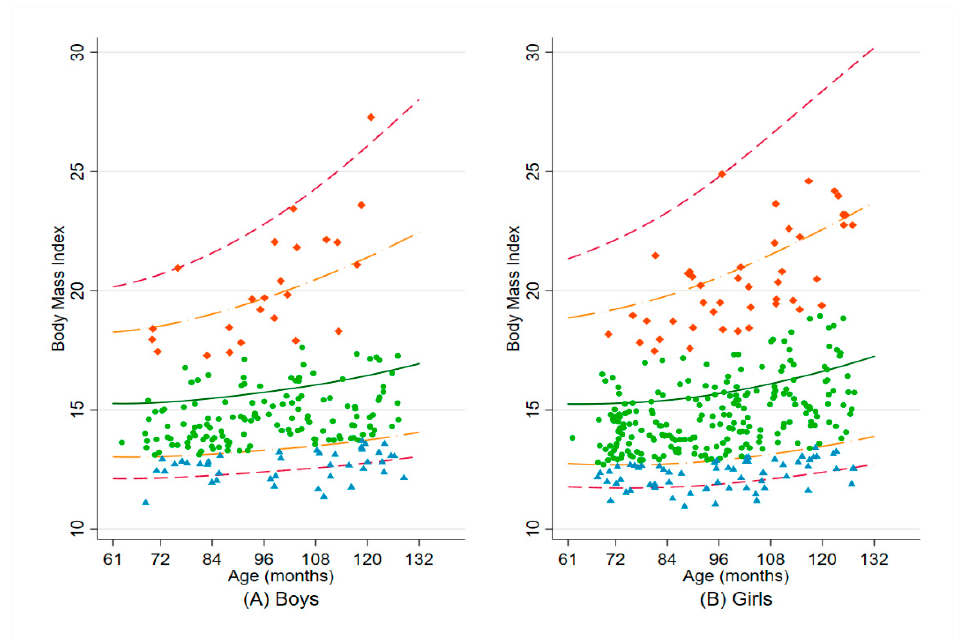
Figure 1. Distribution of BMI by age, from 61 to 132 months, for (A) Boys and (B) Girls. The five lines represent the median (solid dark green line) BMI for age according to the World Health Organization Child Growth Standards, and the SD from the median: ±3 SD (dashed cranberry line) and ±2 SD (long-dash and dotted orange line). Blue triangle indicates child with thinness (BAZ < − 2 SD); light green dot indicates child with normal BMI for age ( − 2 SD ≤ BAZ ≤ +1 SD); orange-red diamond indicates child with overweight/obesity (BAZ > +1 SD). Abbreviations: BMI, body mass index; SD, standard deviation; BAZ, BMI-for-age z-score.